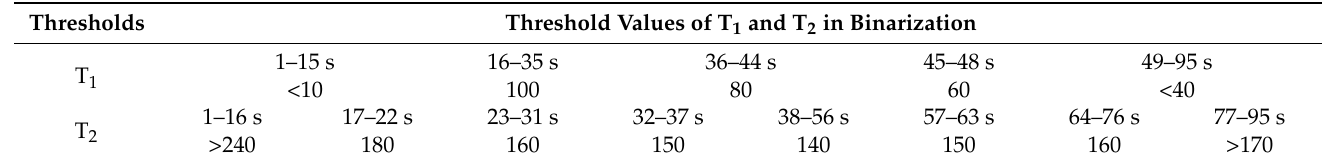
Table 6. Threshold values of T 1 and T 2 with the time nodes of image acquiring.